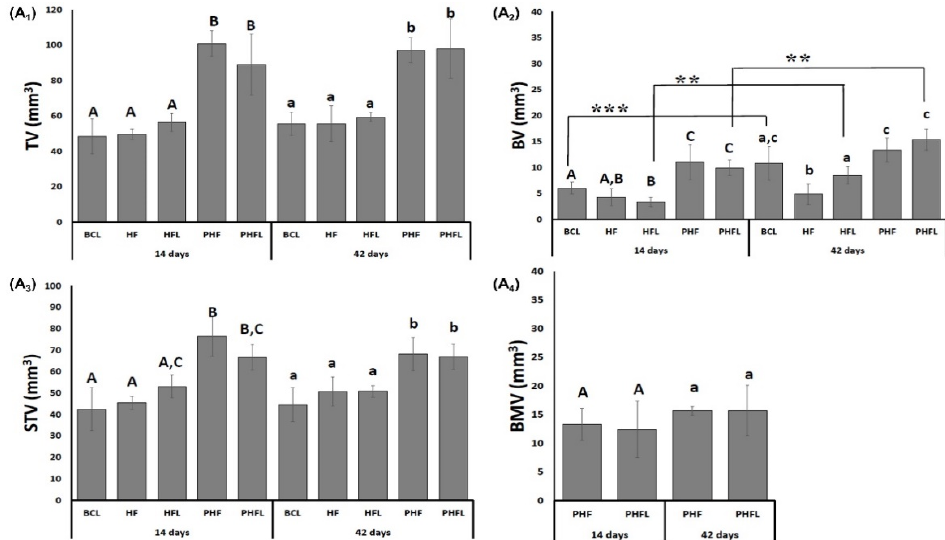
Figure 2. (A) Microtomographic evaluation: Mean and standard deviation graphs of the total volume evaluated, TV, ( A1 ); bone volume, BV, ( A2 ); soft tissue volume, STV, ( A3 ) and the volume of BMV biomaterial particles, ( A4 ). n = 12/group/period. Different uppercase (14 days, A ≠ B ≠ C) and lowercase (42 days, a ≠ b ≠ c) letters, difference between groups/period (Kolmogorov–Smirnov normality test, unpaired Student “ t ” test). Asterisk (** or ***) = significant difference between period/group; (one-way ANOVA and Tukey, p < 0.05).